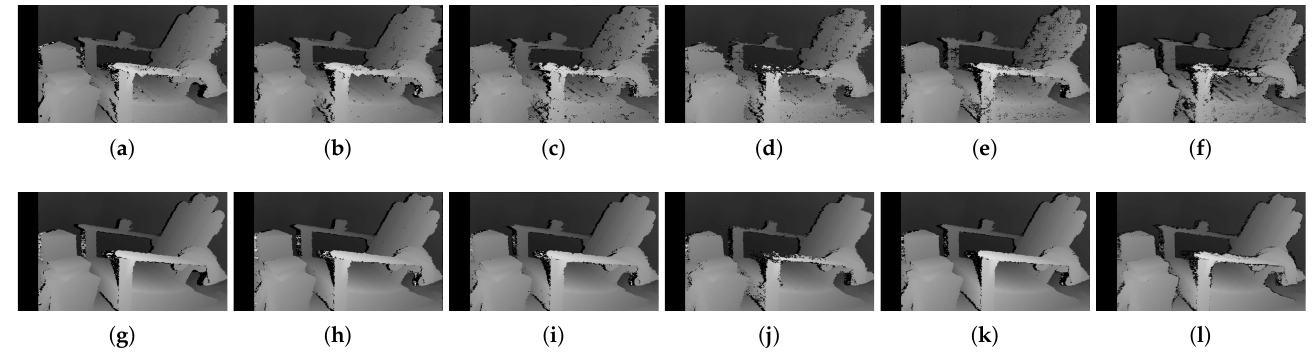
Figure 20. Estimated disparity images of the combinations of cost and image filter using the SGM stereo method, according to low and high parameters for the number of pattern dots . The images in the top row show disparities with the small number of pattern dots , and the images in the bottom row show those with the large number of pattern dots , respectively. ( a ) SGM, AD. ( b ) SGM, Mean/AD. ( c ) SGM, LoG/AD. ( d ) SGM, BilSub/AD. ( e ) SGM, Rank/AD. ( f ) SGM, Census. ( g ) SGM, AD. ( h ) SGM, Mean/AD. ( i ) SGM, LoG/AD. ( j ) SGM, BilSub/AD. ( k ) SGM, Rank/AD. ( l ) SGM, Census.